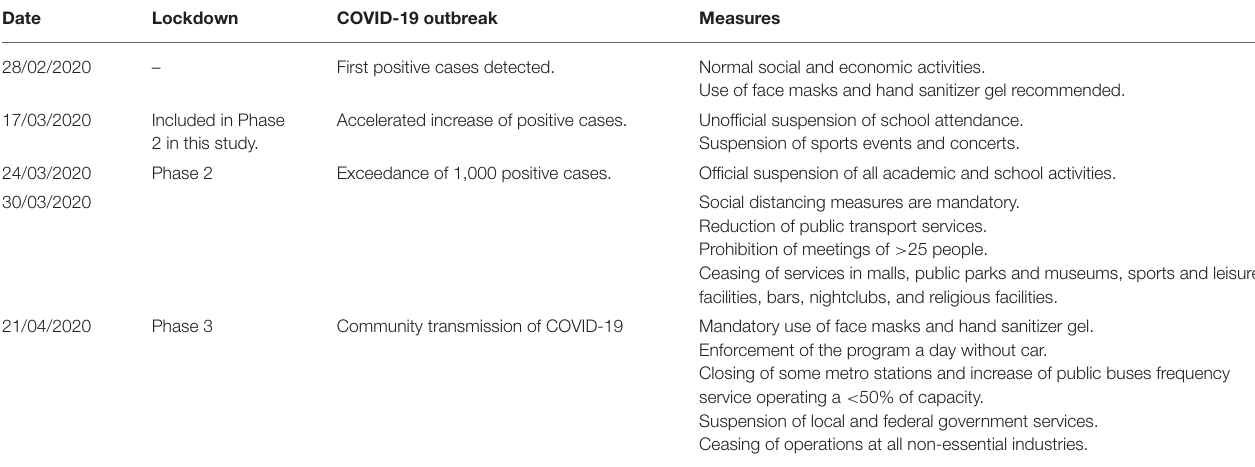
TABLE 1 | Summary of the COVID-19 outbreak propagation and lockdown measures implemented within the